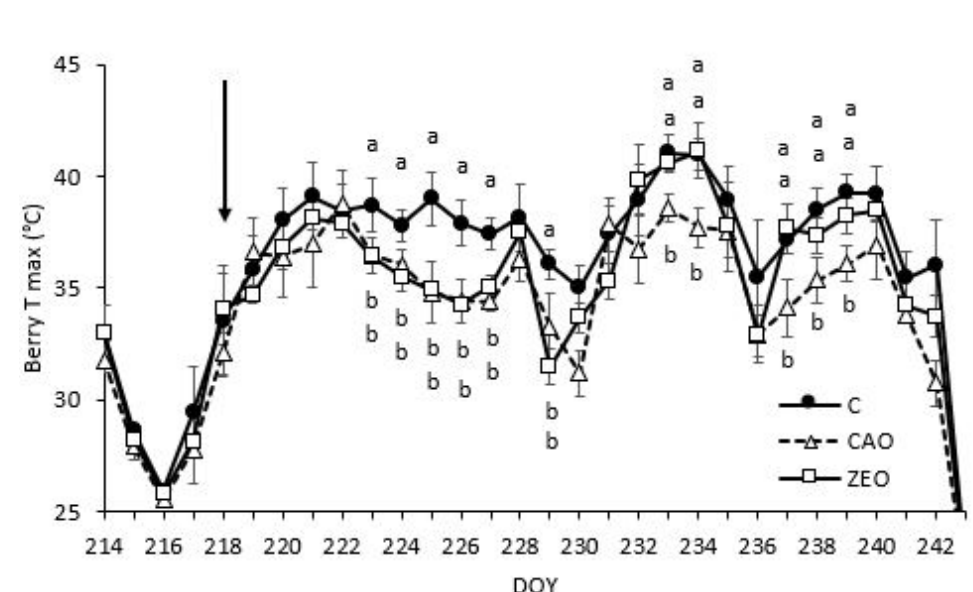
Figure 2. Trend of berry temperature (berry Tmax ◦ C) measured using thermo probes in August 2020. The values are presented as mean ± SE (n = 8 per treatment). Different letters indicate significant differences between treatments according to the Tukey test ( p ≤ 0.05). The arrow indicates the date of the second treatment with mineral